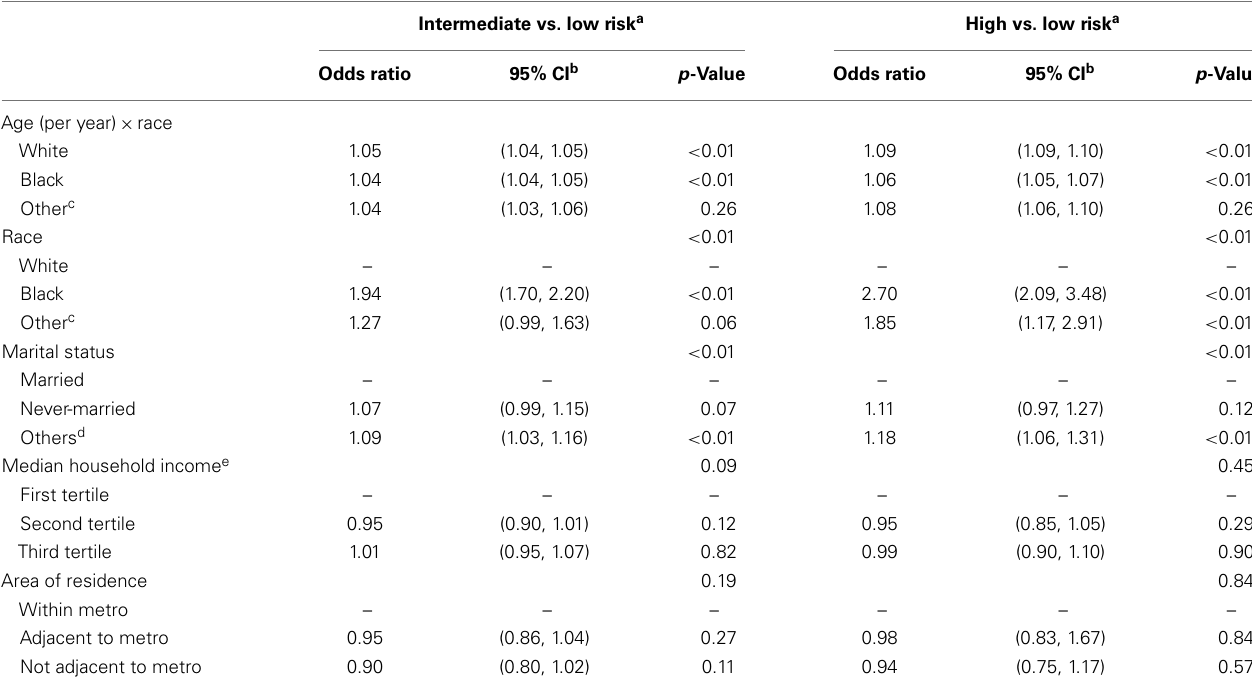
Table 6 | Multivariate logistic regression analyses modeling the probabilities of patients with PSA < 10ng/ml intermediate-risk disease vs. low-risk disease, and of patients with PSA < 10ng/ml high-risk diseases vs. low-risk disease respectively